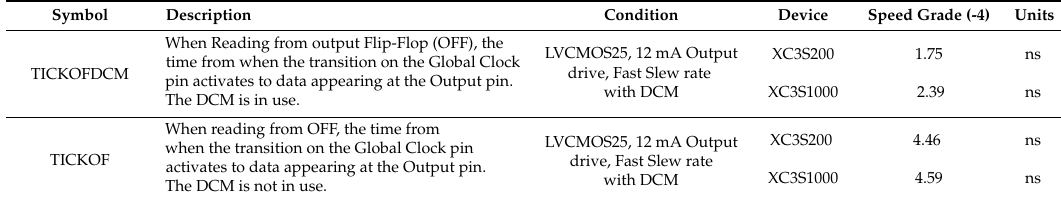
Table 2. Clock-to-Output Times for the XC3S200 and XC3S1000 from the developed device using 50 MHz integrated clock circuit from each board.